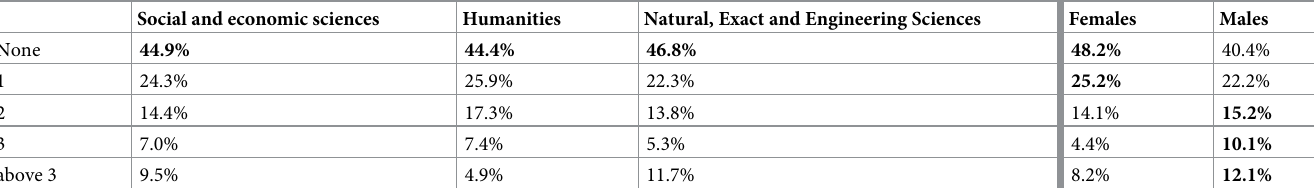
Table 4. Number of applications that obtained funding by the fundamental area of interest and by gender. Social and economic